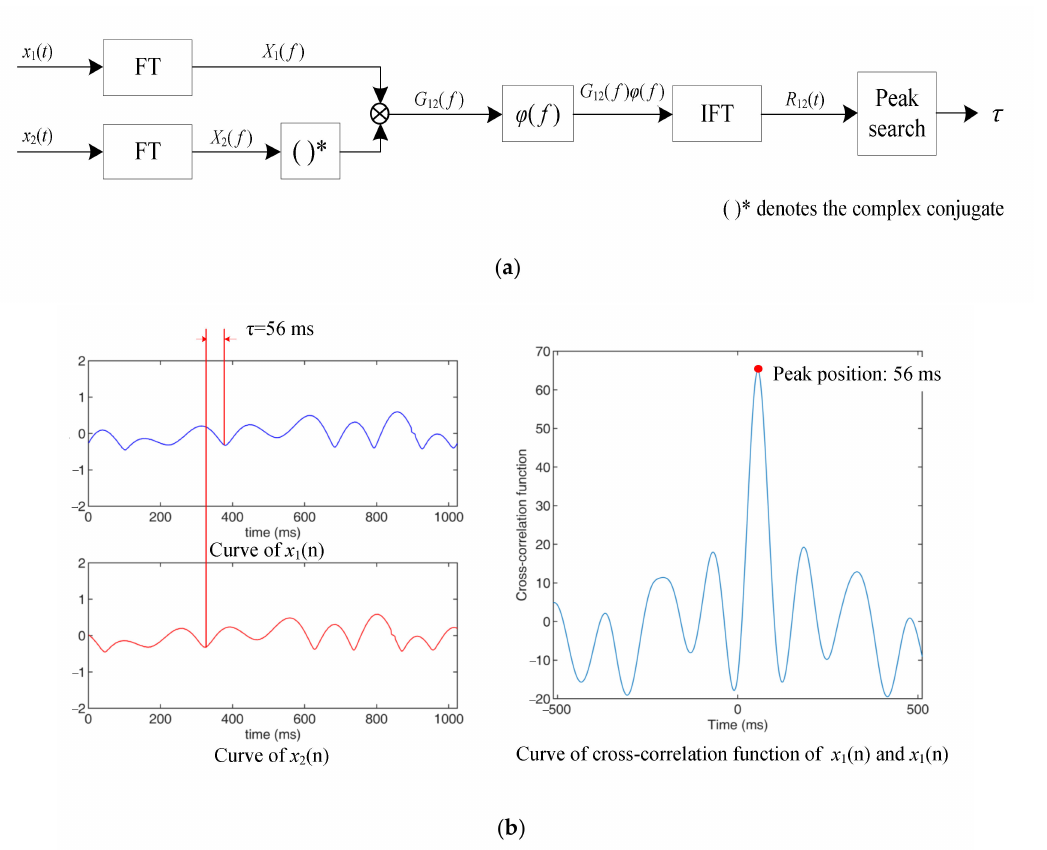
Figure 1. Time delay estimation principle of the GCC method: ( a ) flowchart of the GCC method; ( b ) a typical example of time delay estimation using the cross-correlation method.